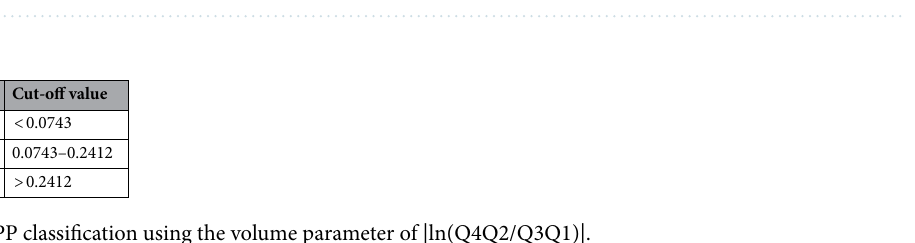
Table 6. PP classification using the volume parameter of